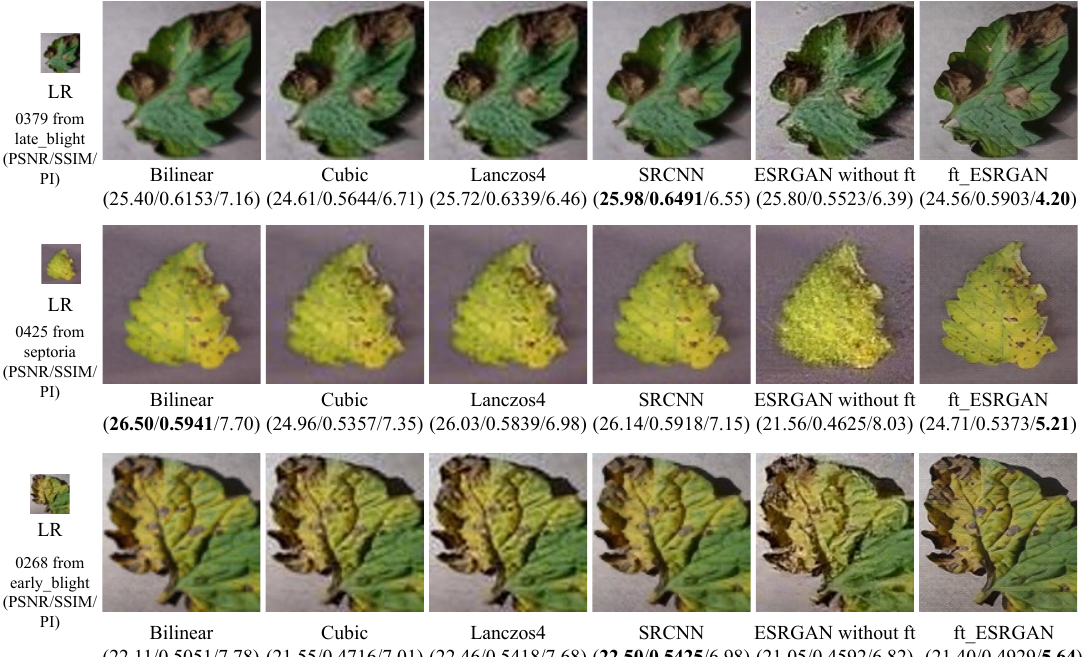
Figure 7. Examples of generated SR images. Our ft_ESRGAN produces sharper and more natural texture with richer visual information. “ESRGAN without ft” in the sixth column means ESRGAN without fine-tuning. And “ft_ESRGAN” in the seventh column means ESRGAN with second fine-tuning. [ × 4